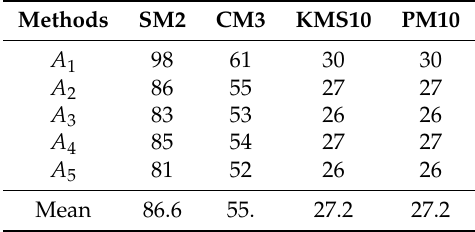
Table 3. Comparison based on the number of iterations and the required mean in Experiment 2.